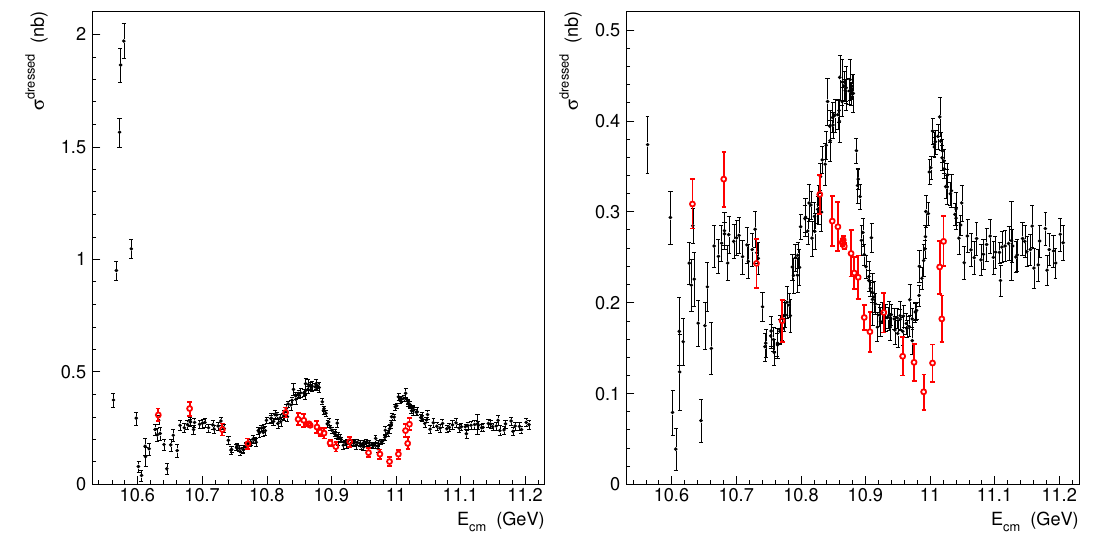
Figure 9 . Energy dependence of the total b ¯ b dressed cross section obtained in ref. [19] from the visible cross sections measured by Belle [22] and BaBar [1] (black dots). Open red circles represent the sum of the exclusive B ¯ B , B ¯ B ∗ , and B ∗ ¯ B ∗ cross sections measured in this work. Right panel is a zoom of the low cross section region.